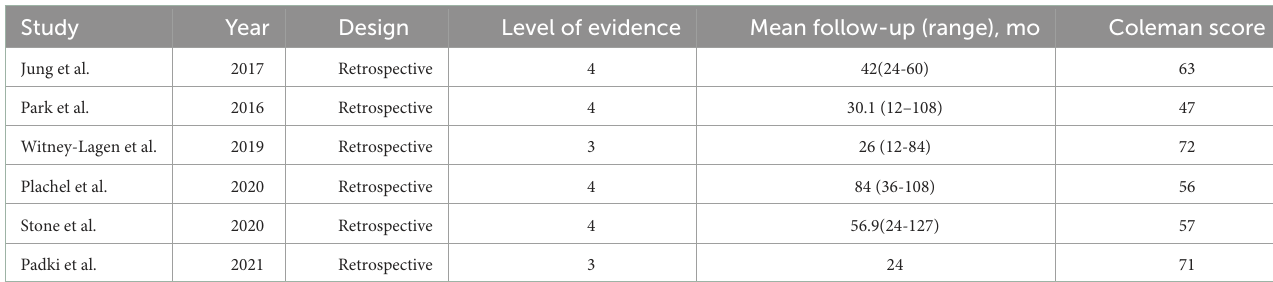
TABLE 1 Study characteristics.